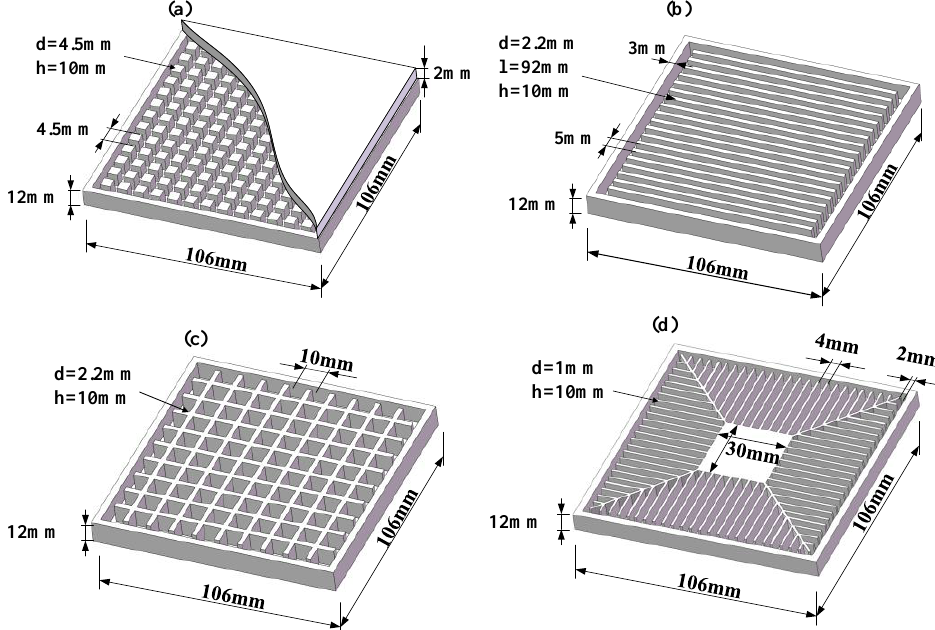
Figure 1. Physical model of fins with different structures of ( a ) a discrete columnar-shaped structure, ( b ) a continuous bar-shaped structure, ( c ) a continuous square-shaped structure, and ( d ) a continuous sunflower-shaped structure.